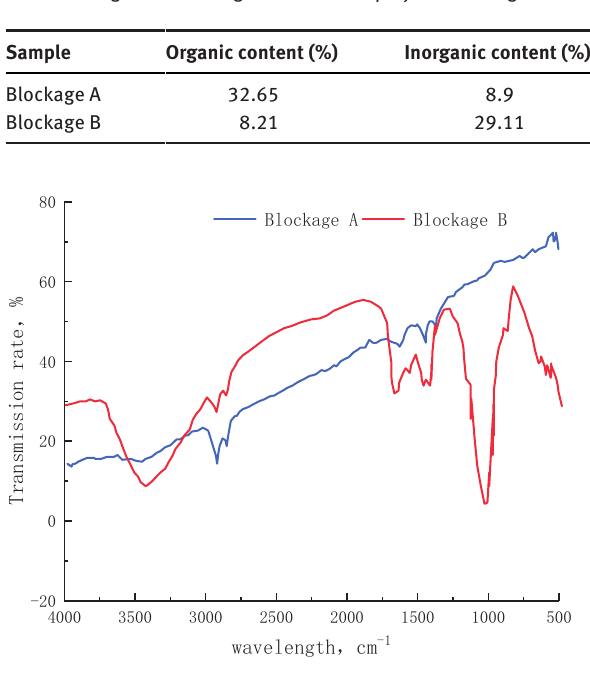
Figure 2: FTIR spectra of polymer blockages.